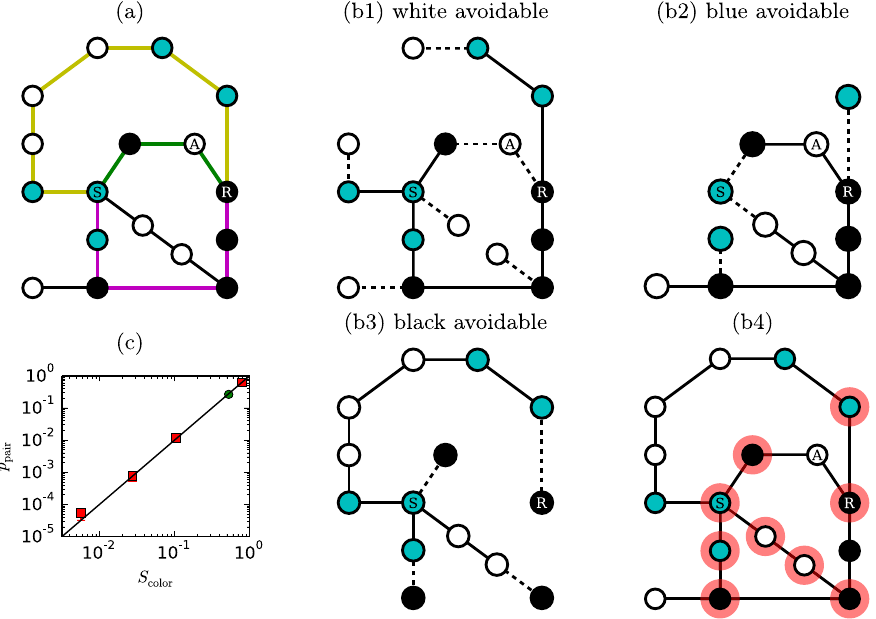
FIG. 2. Illustration of color-avoiding connectivity. (a) In this network, the sender S and the receiver R are color-avoiding connected (CAC), as the green path avoids blue nodes, the purple path avoids white nodes, and the yellow path avoids black nodes. (b) Finding L , the largest color-avoiding connected component. (b1) The largest component without white nodes ( L ¯ ) and its direct white color white neighbors (links to white neighbors are dashed) form L þ . Each pair of nodes in this component ( L þ ) can communicate, avoiding white white white nodes on the path between sender and receiver. We repeat the process in (b2) for blue and in (b3) for black nodes. (b4) Nodes that belong to all three components (in red) constitute the largest CAC component, L . Note that some nodes are not CAC but are color necessary to form the largest color-avoiding component, for example, node A. This node is not in L þ [see (b3)]. However, it is still black required to form a path avoiding blue nodes between nodes S and R [see (a)]. (c) Total CAC pairs p compared to the size of the giant pair ¯ k ¼ 1 . 6 , 1.7, 1.9, CAC component ( S ) for quenched graphs. Red squares show Poisson graphs with N ¼ 10 5 nodes, average degrees color 4.0 (from left to right) and C ¼ 3 colors; the green circle shows the AS-level Internet [34,35], with colors representing countries as described in Fig. 4. The black line S 2 ¼ p pair represents all CAC occurring within the giant CAC component. Note that p pair was color approximated with samples of up to 5 × 10 5 pairs; error bars are smaller than the visible